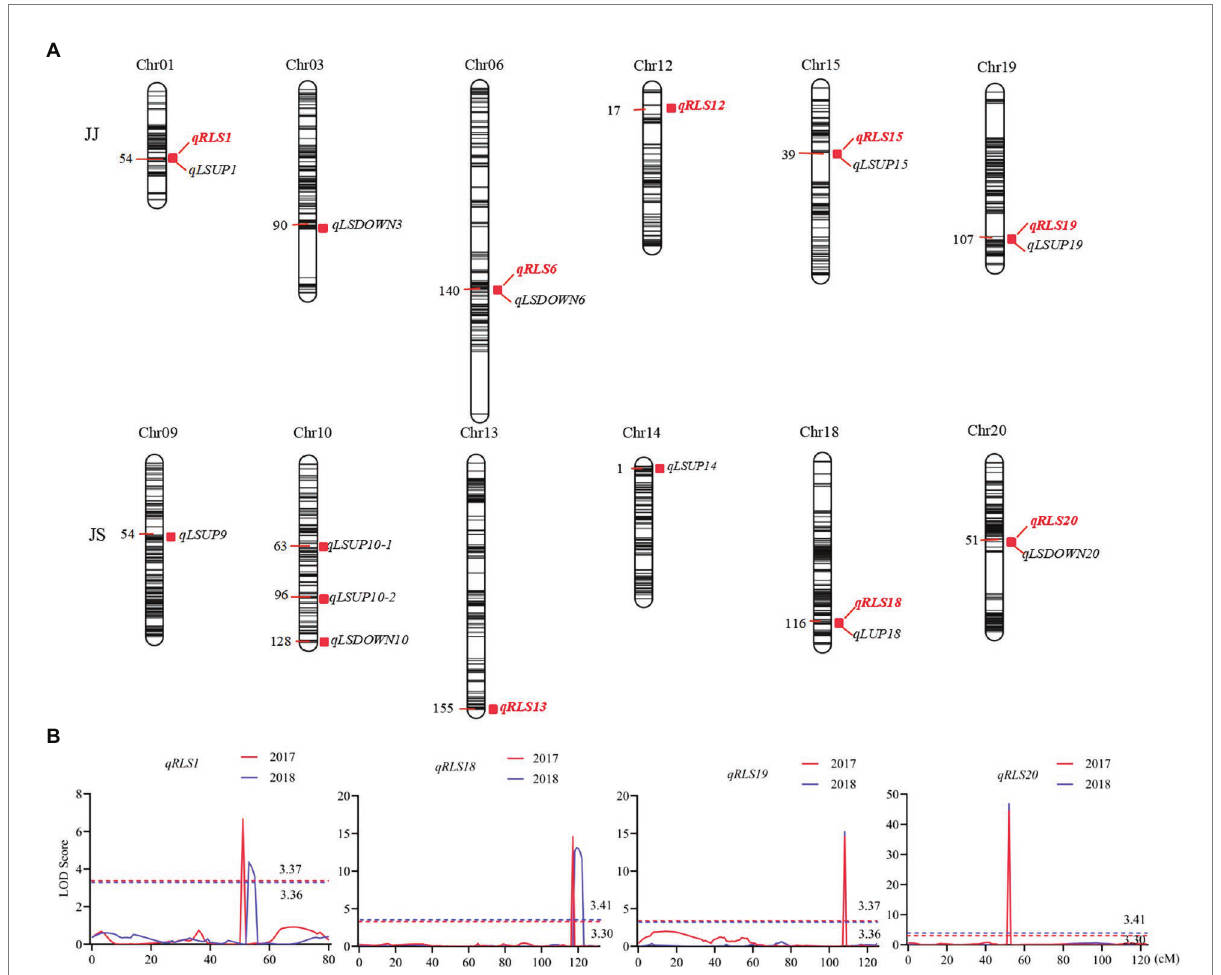
FIGURE 3 QTL controlling leaf shape characteristics in the two RIL populations. (A) QTL hotspots of leaf characteristics in the two RIL populations. The color intensity of the bar chart represents marker density. The number on the left indicates genetic distances in centimorgan (cM). QTL names are shown on the right. (B) LOD curves of the four QTL for the ratio of the leaf shape index (RLS). Different colors represent different environments. The curve for data from the 2017 cropping season is in red and that from 2018 in blue. The dashed line indicates the threshold LOD score. The x-axis shows genetic positions in the